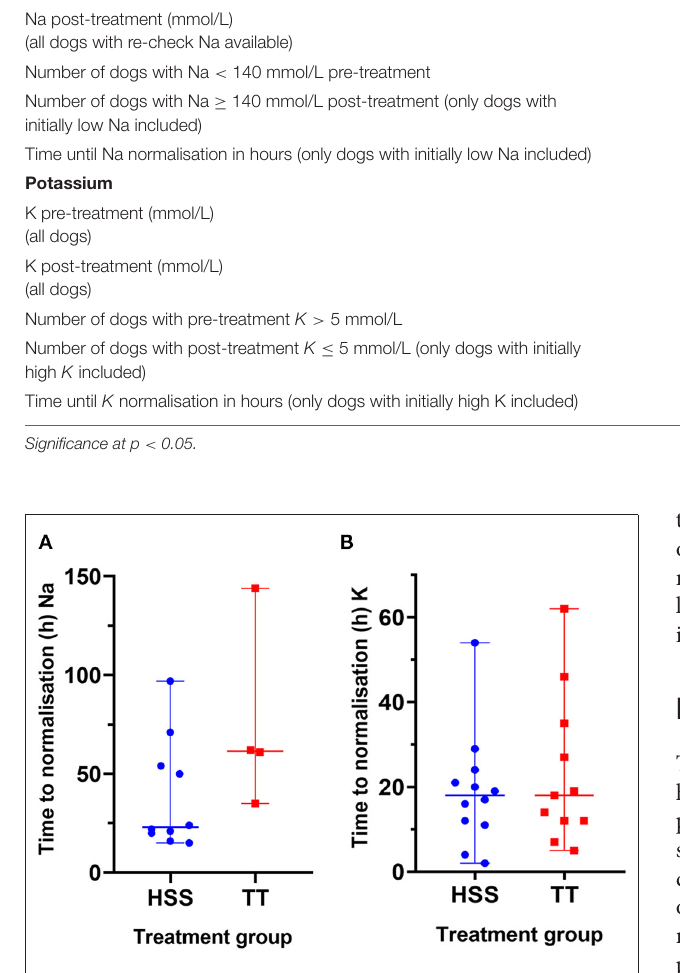
FIGURE 2 | Comparison of time to normalisation of sodium (A) and potassium (B) concentration between the HSS (blue dots) and TT group (red rectangles). Horizontal line represents median, whiskers represent